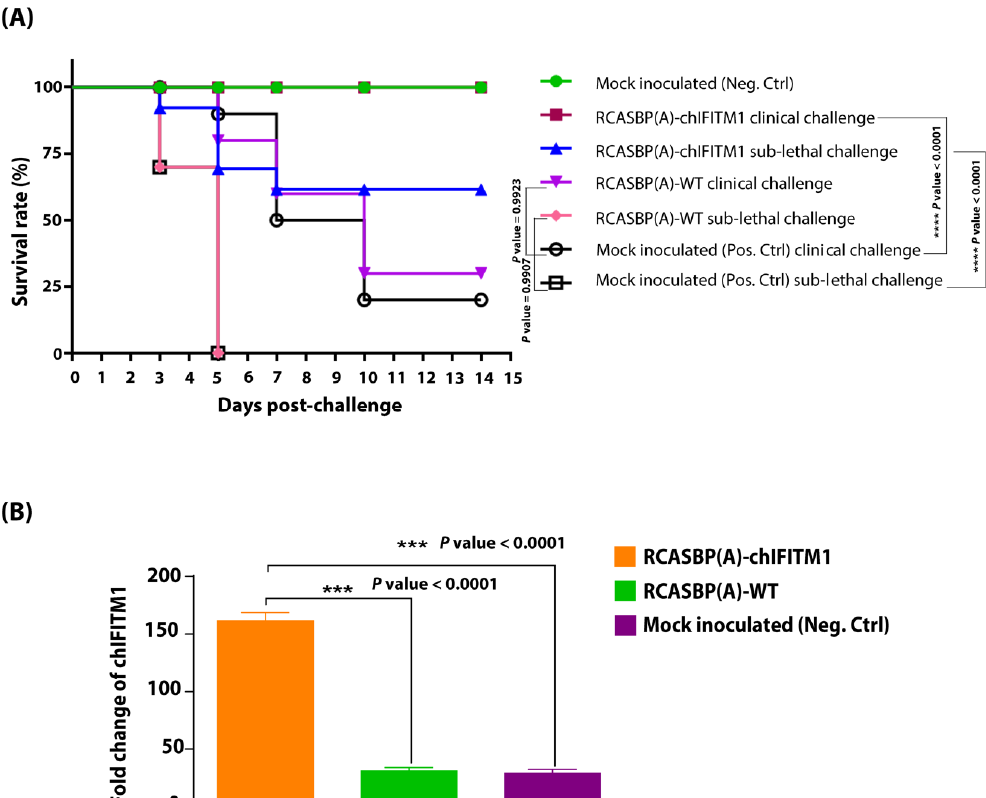
Figure 3. Survival rates and chIFITM1 expression quantification. ( A ) Percentage survival rates of RCASBP(A)-chIFITM1 and RCASBP(A)-WT challenged chicks with clinical and sub-lethal doses of H5N1 HPAIV compared to mock inoculated chicks (negative and positive control groups). ( B ) Expression of chIFITM1 in HPAI H5N1 challenged transgenic chickens with RCASBP(A)-chIFITM1 compared to transgenic chickens (RCASBP(A)-WT) and non-transgenic chicken (mock inoc- ulated neg. ctrl), asterisks indicate significant difference.